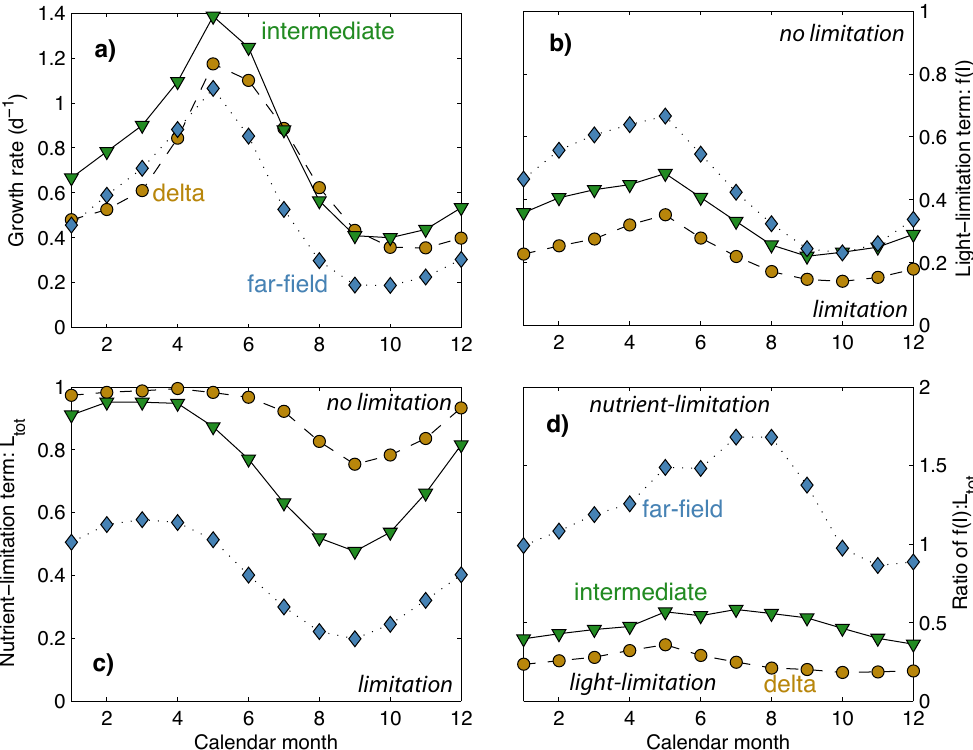
Fig. 13. Monthly climatology of simulated mixed layer mean phytoplankton growth rate (a) , light-limitation term (b) , nutrient-limitation term (c) and ratio of light- and nutrient-limitation (d) for the delta, intermediate and far-field